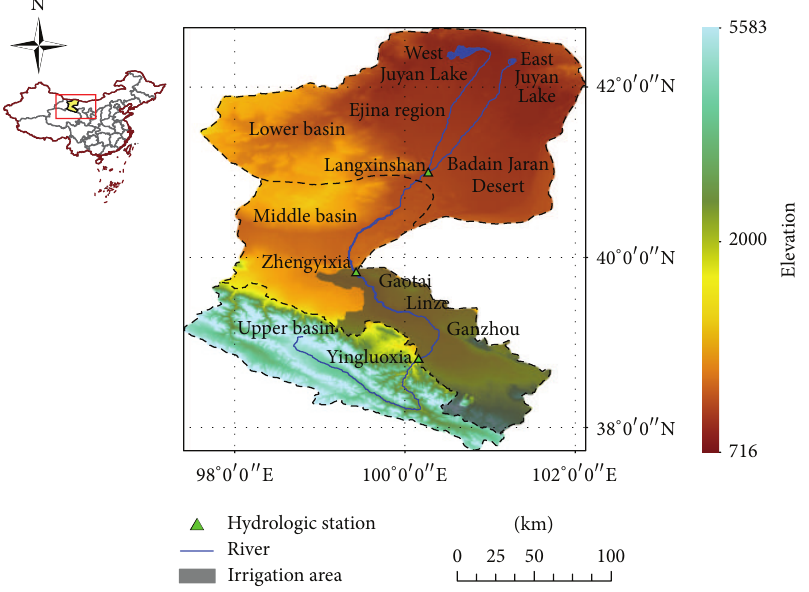
Figure 1: Map of study